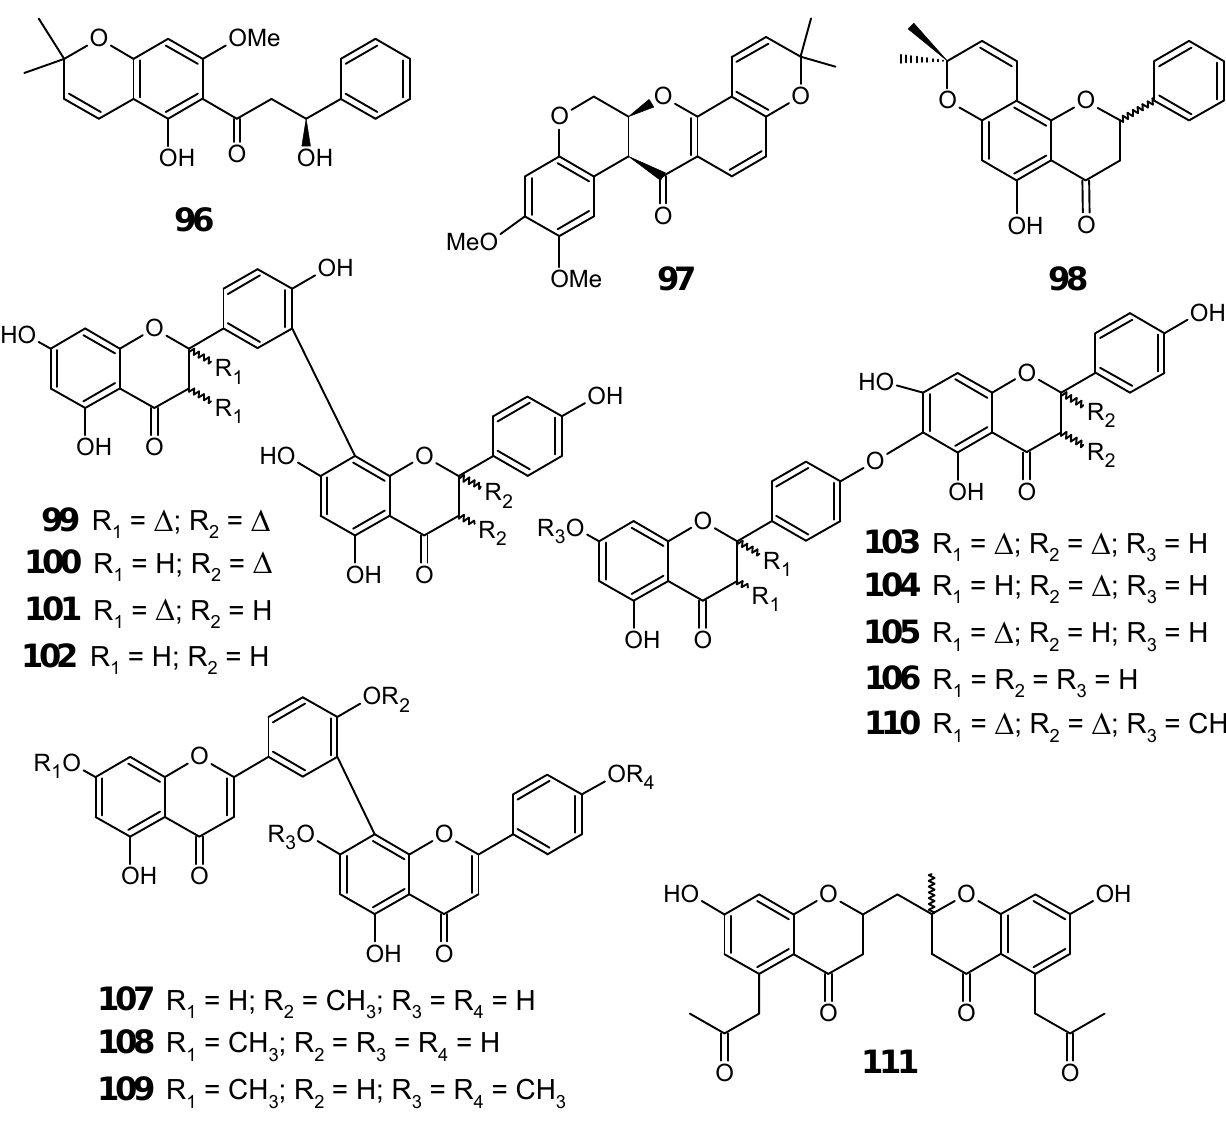
Figure 11. Antiplasmodial flavonoids and related compounds 96-111